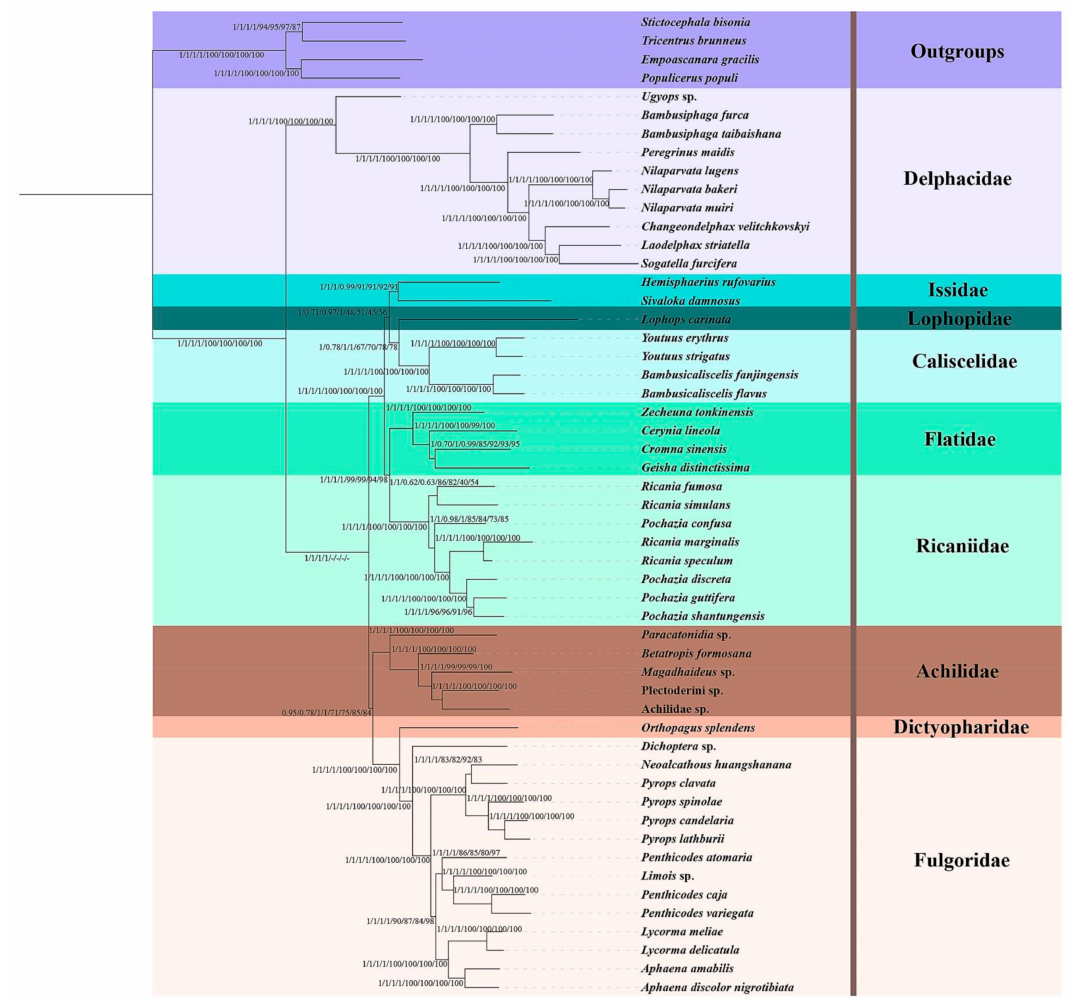
Figure 8. Phylogenetic tree obtained from IQ-TREE and MrBayes based on the data sets of PCG, PCGRNA, PCG12, and PCG12RNA. The numbers at nodes (from left to right) are Bayesian posterior probabilities (PPs) and then ML bootstrap support values